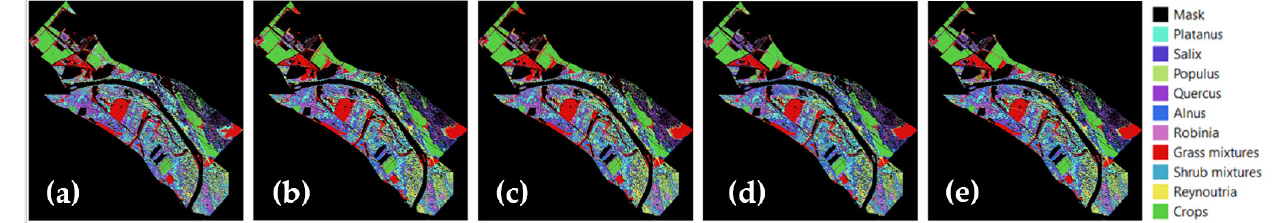
Figure 5. Classification maps obtained with ( a ) RF, ( b ) SVM-linear, ( c ) SVM-RBF, ( d ) RLR-ℓ1, and ( e ) RLR-ℓ2.